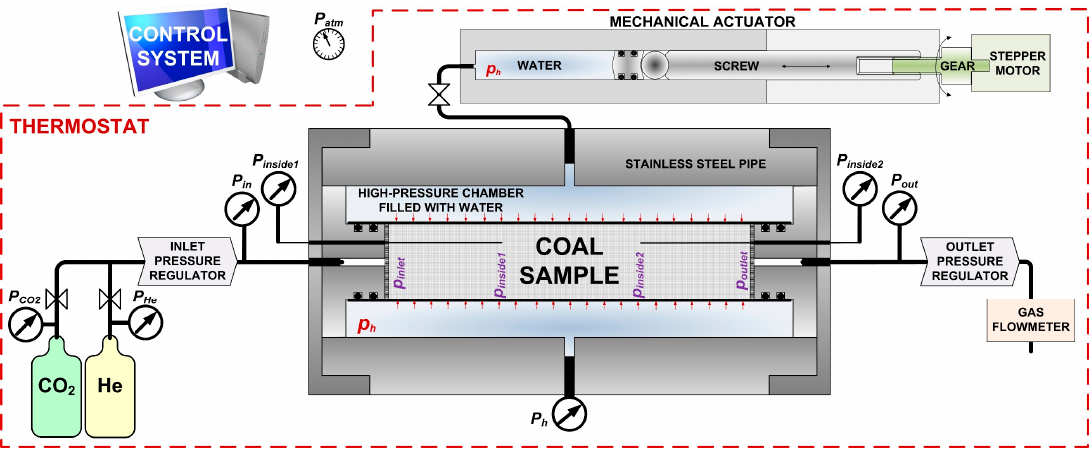
Figure 1. Scheme of the measuring apparatus for testing seepage under confining pressure conditions.